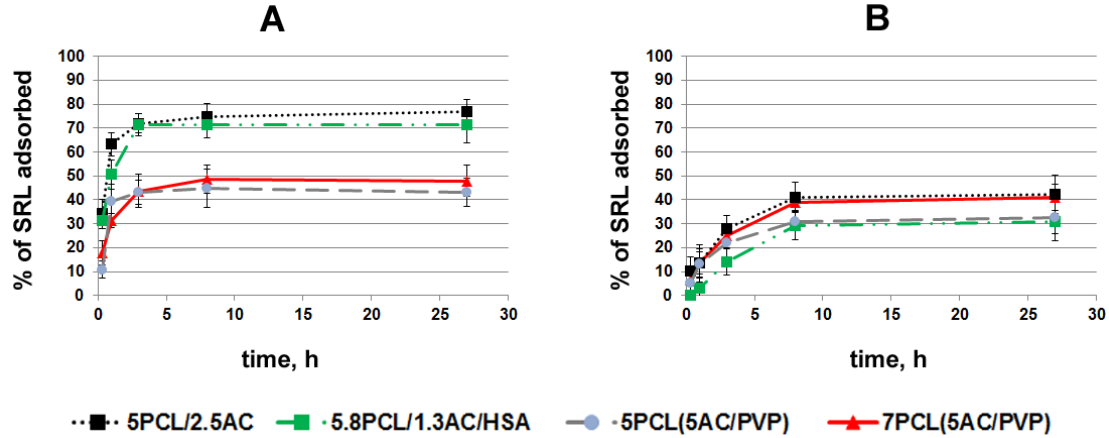
Figure 5. Kinetic curves of SRL adsorption onto ACN-enriched scaffolds in PBS ( A ) and in BP ( B ). The comparison of kinetic curves revealed that the scaffolds of 7PCL (5AC/PVP) and 5PCL/2.5AC effectively adsorb SRL in BP and may be used in biological